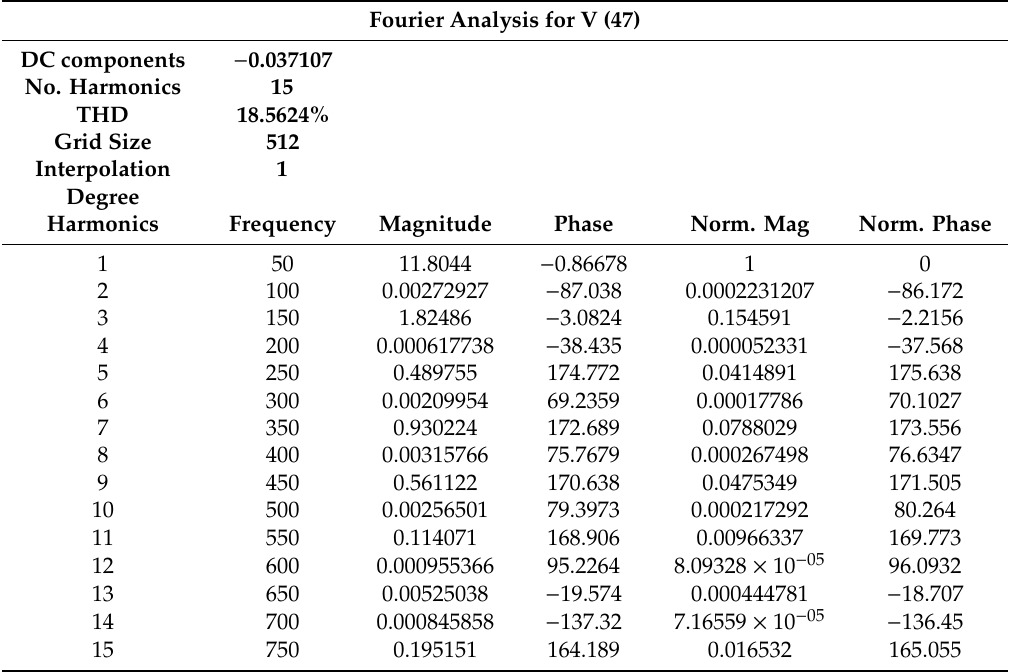
Table 10. Total harmonic